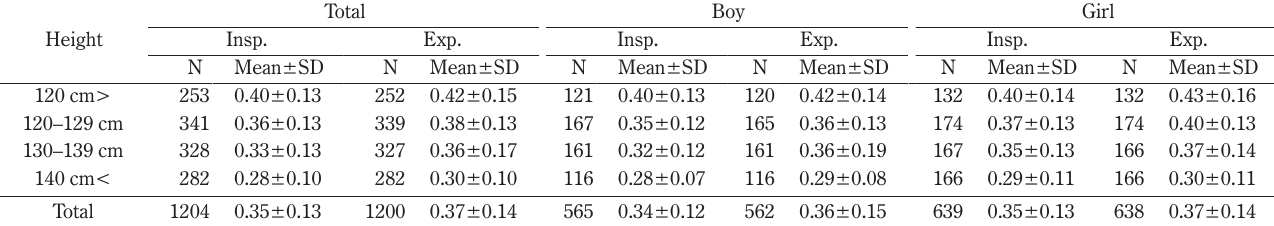
Table 2 Bilateral nasal resistance in normal children and body